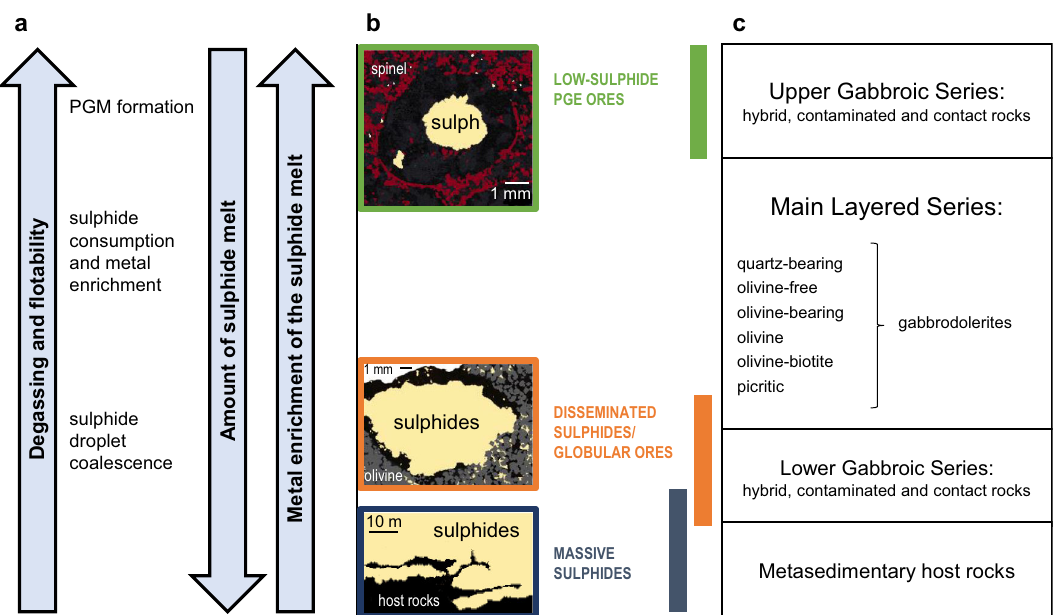
Fig. 6 Proposed scenario for ore type formation in Noril ’ sk-Talnakh intrusions. a Scheme showing how fl oatability and metal enrichment of the sulphide melt increase with increasing degassing, whereas the amount of sulphide melt decreases. b Magmatic sulphide ore types in Noril ’ sk-Talnakh deposits and ( c ) their distribution within the intrusion. From top to bottom in ( b ), schematic drawings of: the subspherical shapes described in low-sulphide PGE ores within the Upper Gabbroic Series (as observed in refs. 39,40 ); the subspherical shapes in globular ores within the picritic rocks of the Main Layered Series and the taxitic rocks of the Lower Gabbroic Series (as observed in refs. 15,16 ); massive sulphide ores within the metasedimentary host rocks (as observed in refs. 22,41 ).